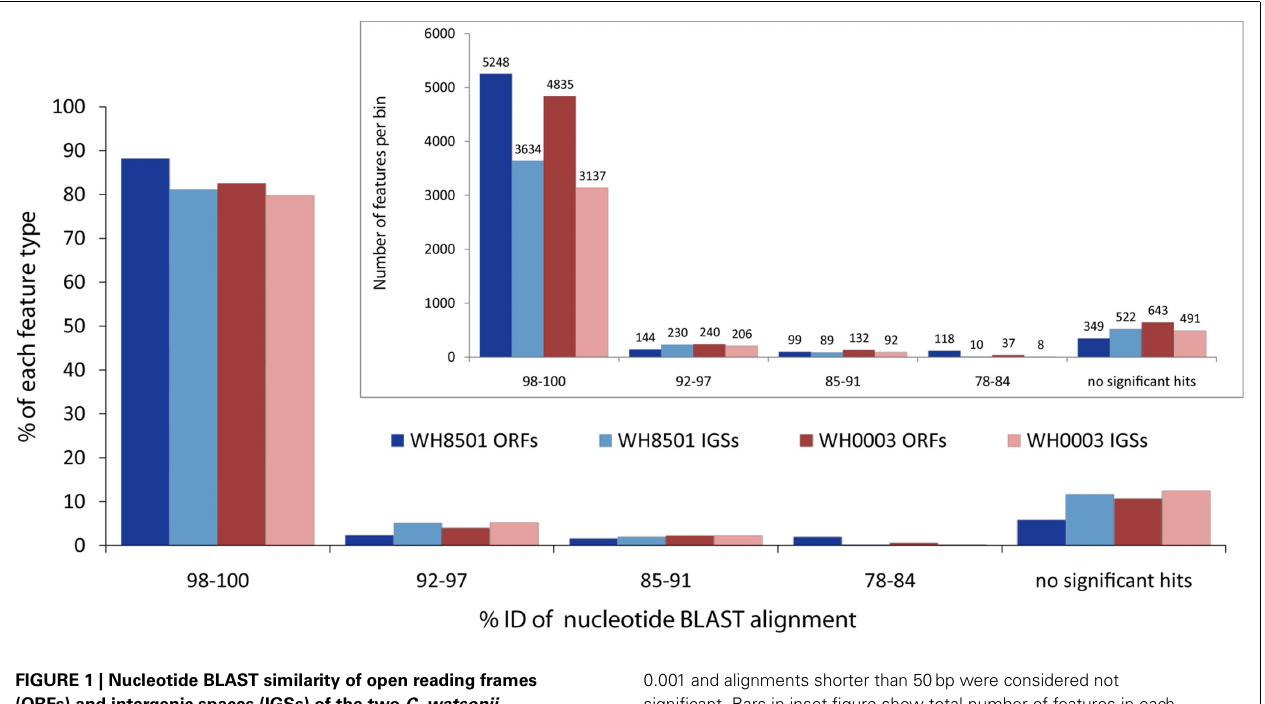
FIGURE 1 | Nucleotide BLAST similarity of open reading frames (ORFs) and intergenic spaces (IGSs) of the two C. watsonii genomes to the opposite strain. Each feature was binned according to the percent identity of the top BLAST alignment. E -values above